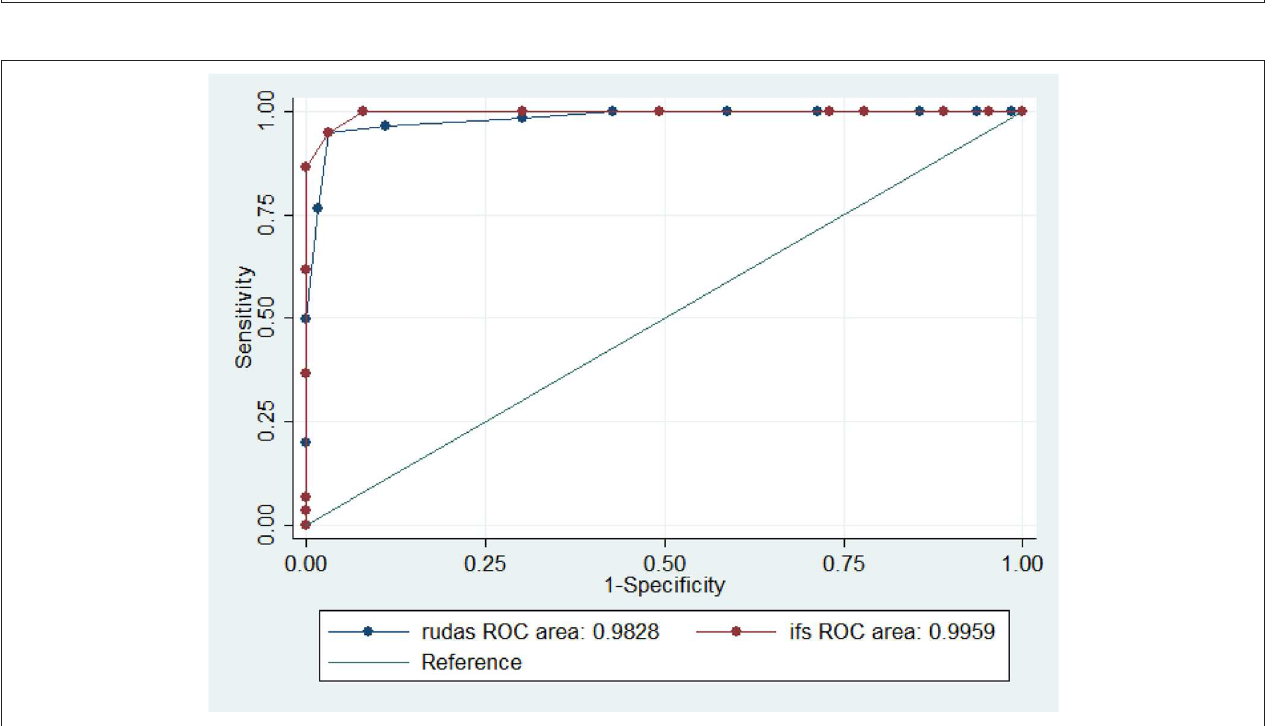
FIGURE 3 | Receiver-operating characteristic (ROC) curve of the Peruvian version of the Rowland Universal Dementia Assessment Scale (RUDAS-PE) and the INECO Frontal Screening (IFS) in 124 patients for discrimination between mild cognitive impairment (MCI) and control groups. Centros de Salud de Ventanilla, Callao, Lima.